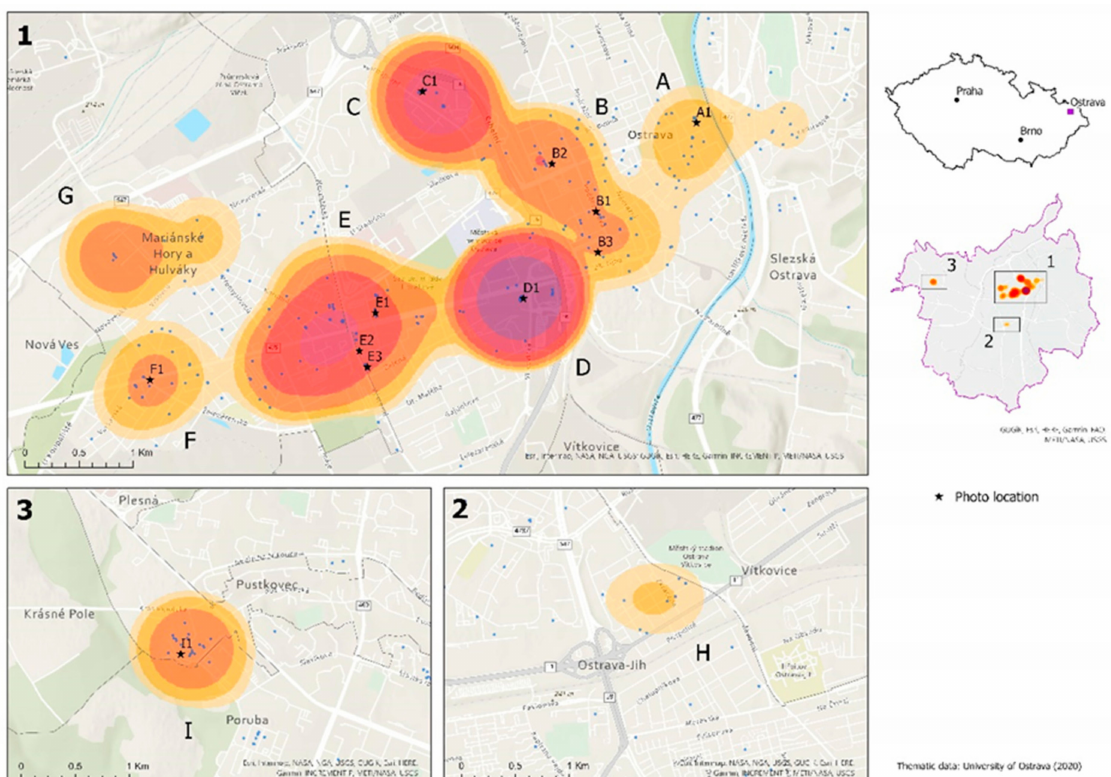
Figure 4. The detailed locations for ICT hubs in the city of